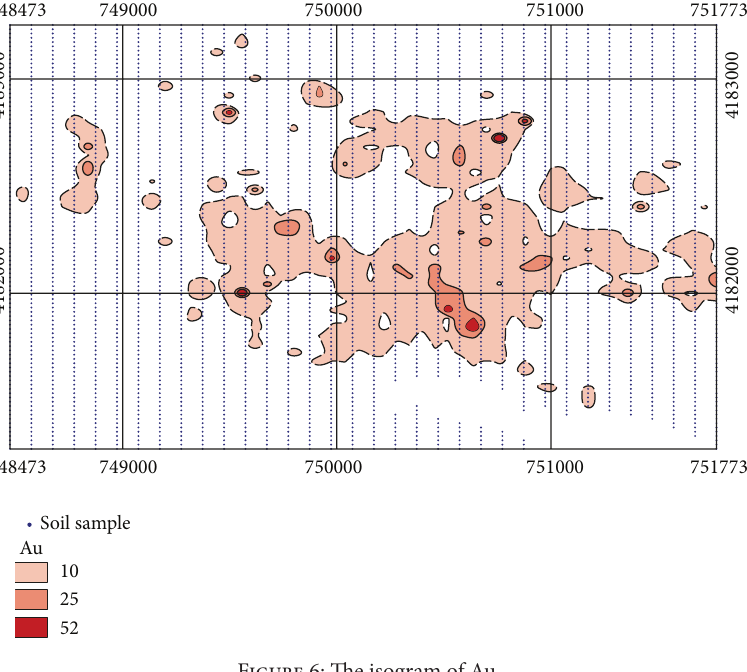
Figure 6: The isogram of Au.